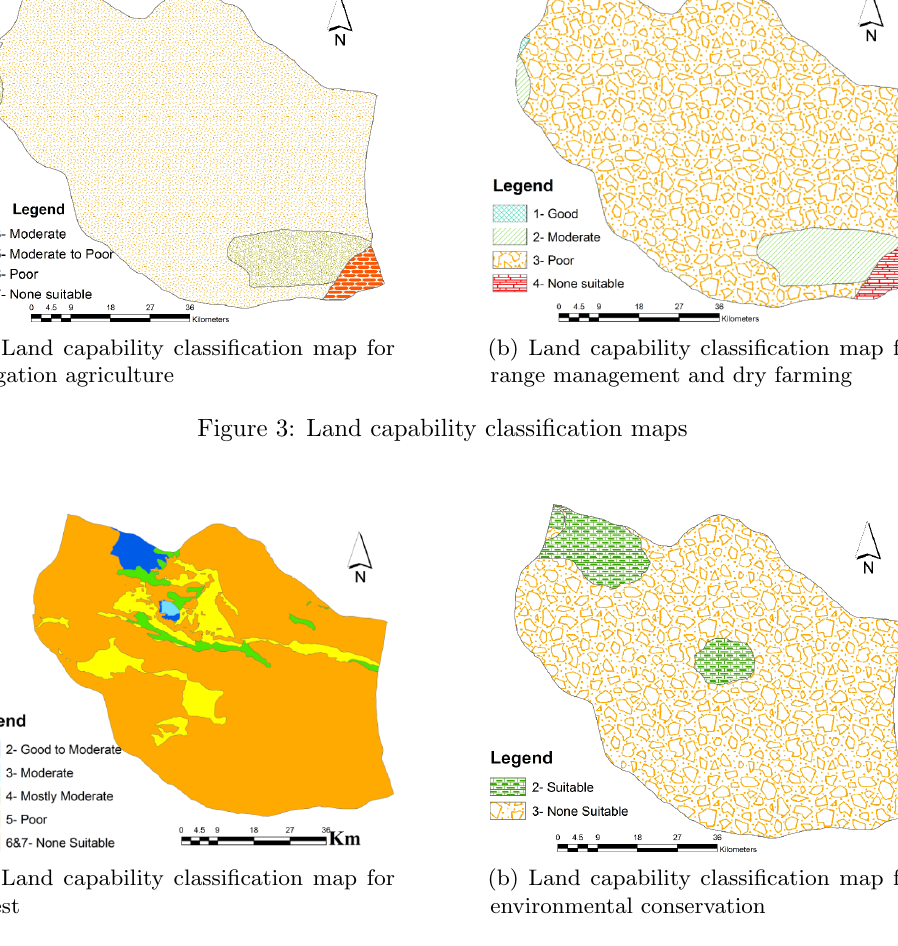
Figure 4: Land capability classification